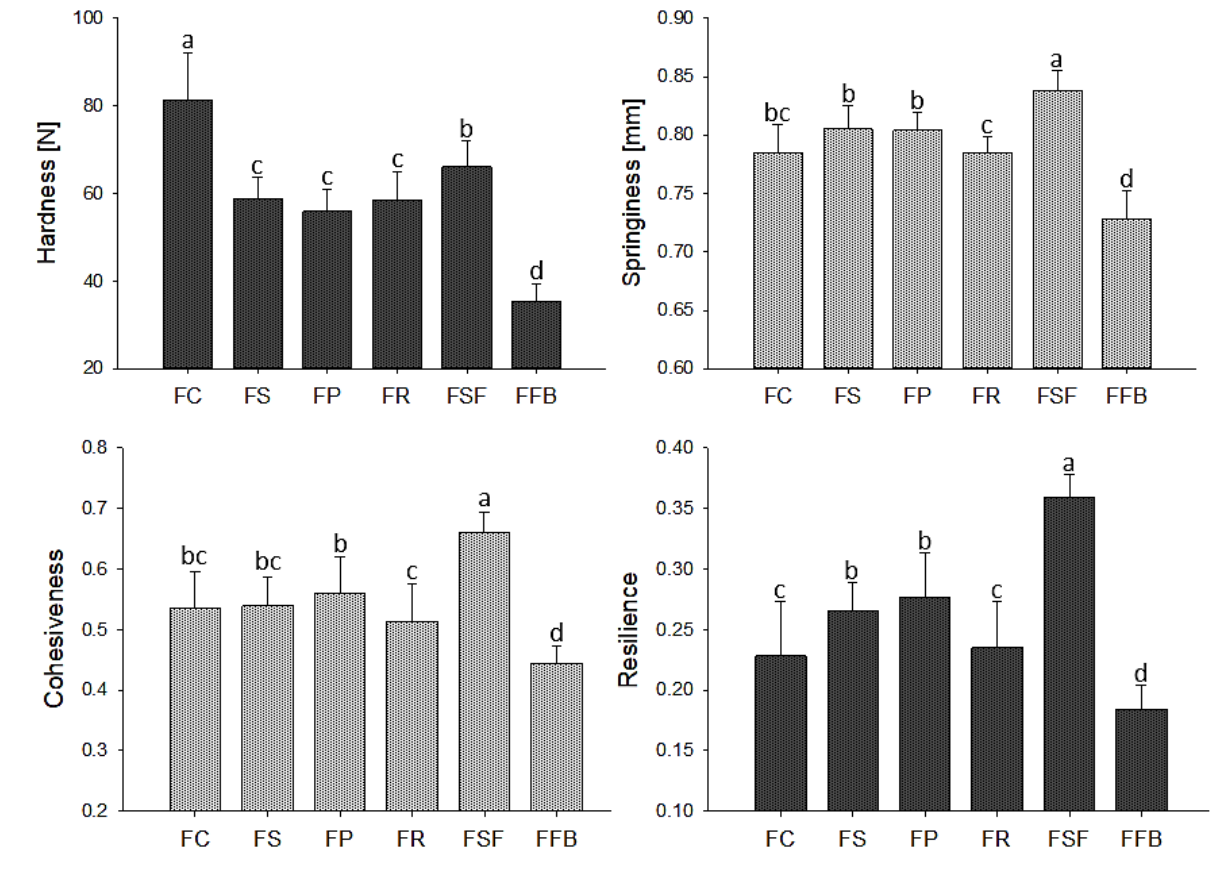
Figure 3. Mean values for texture parameters of hybrid meat emulsions elaborated with plant proteins as partial meat substitutes. FC: control; FS: soy; FP: pea; FR: rice; FSF: sunflower; FFB: fava bean. Mean values with different letters on the columns of each parameter differ from each other ( p ≤ 0.05 ) according to the post hoc Tukey ’ s test.